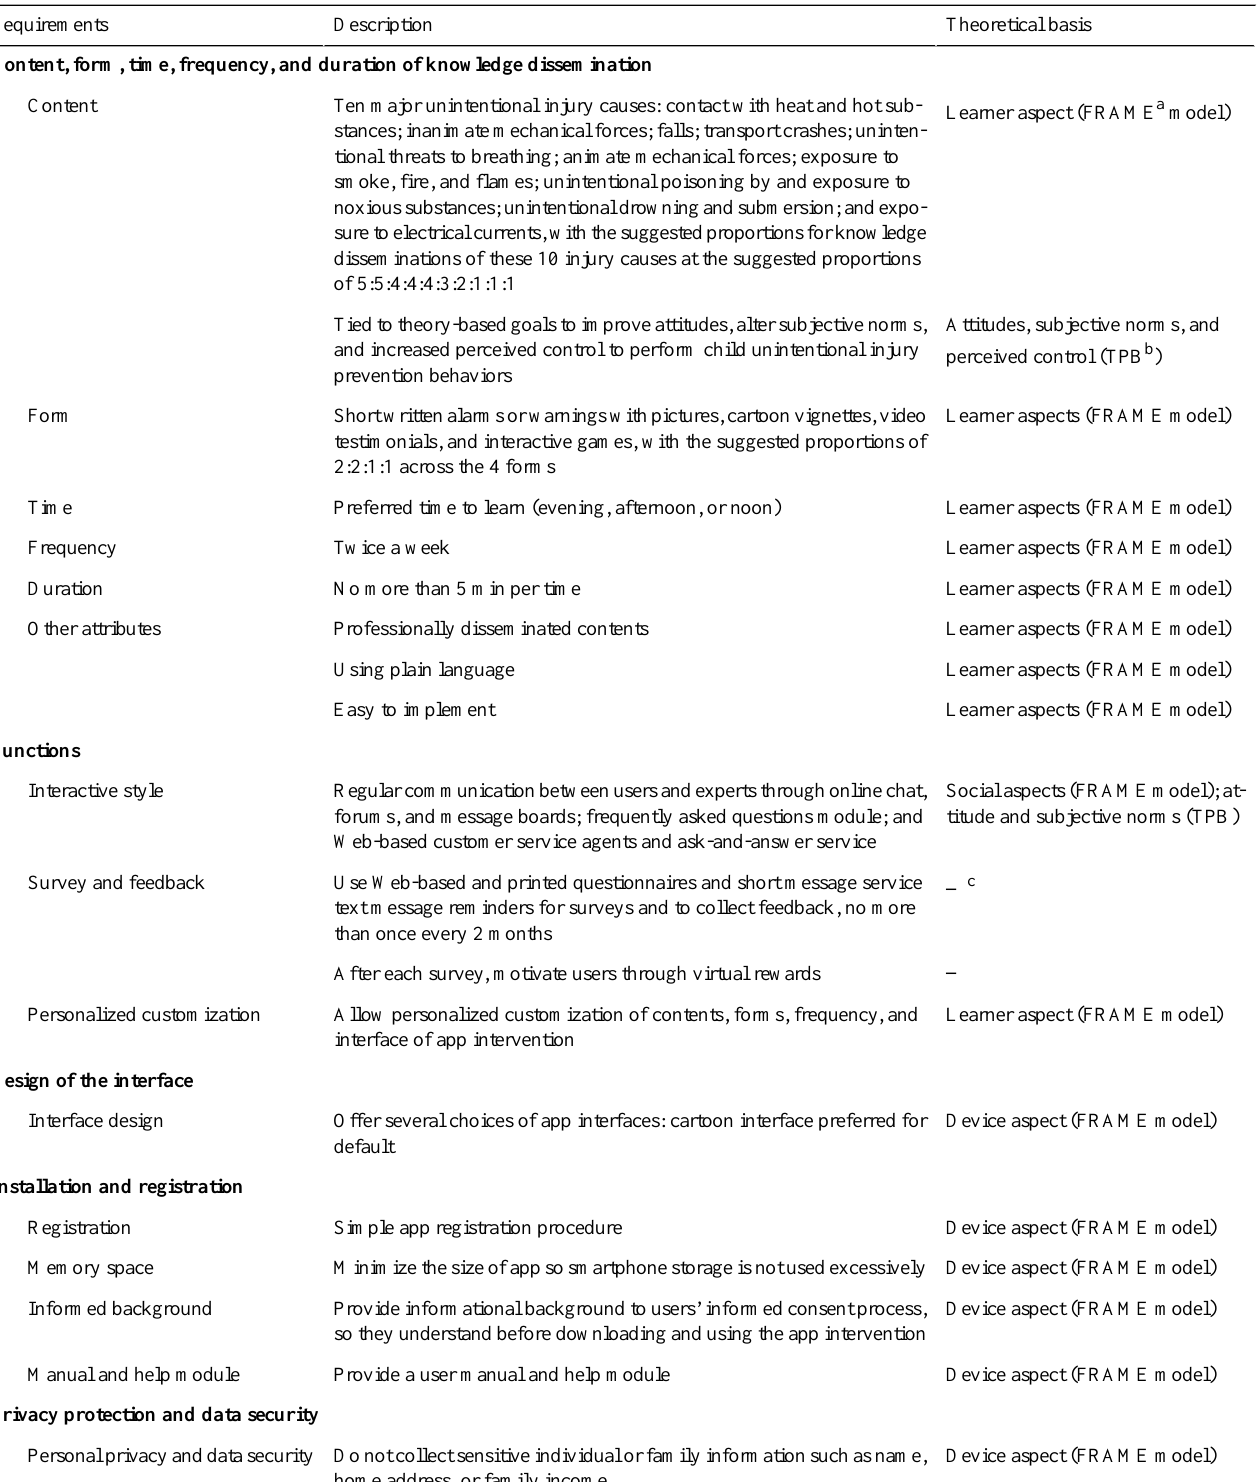
Table 3. Framework for developing an app to teach knowledge about preventing child unintentional injury to Chinese caregivers of children aged 0 to 6 years.